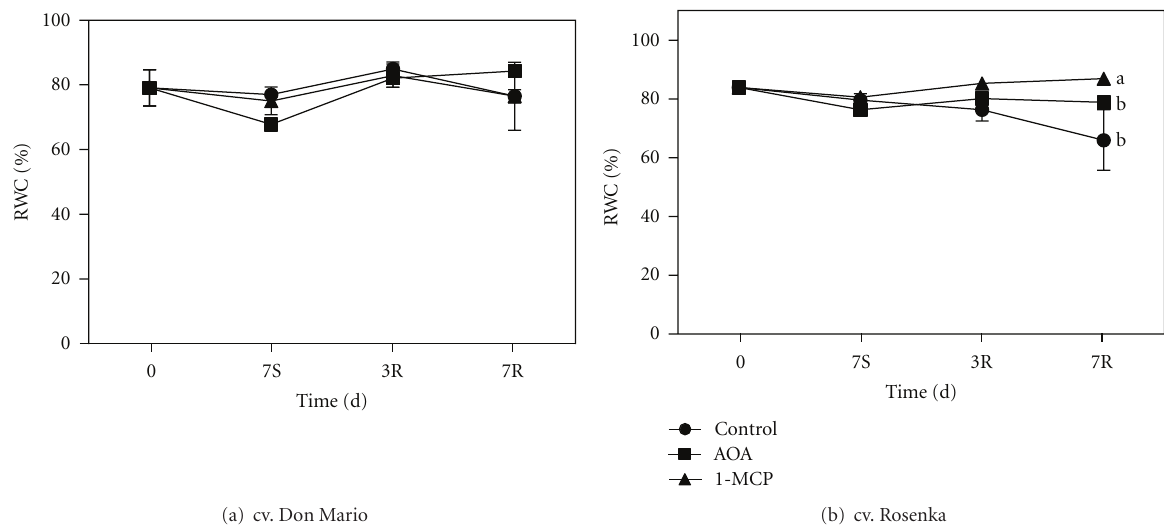
Figure 2: Relative water content (RWC) measured from leaves of cv. Don Mario (a) and cv. Rosenka (b) stored for 7 days (7S) at 14 ◦ C and transferred at 20 ◦ C for recovery evaluation (3R and 7R). Values are means with standard errors ( n = 10). Data were subjected to two-way ANOVA, and di ff erent letters, when present, mean that values are statistically di ff erent, P < 0 . 05. of 1-MCP-treated plants showed an increase of ethylene production, reaching the initial values. The AOA-treated leaves, instead, after seven days showed the lowest